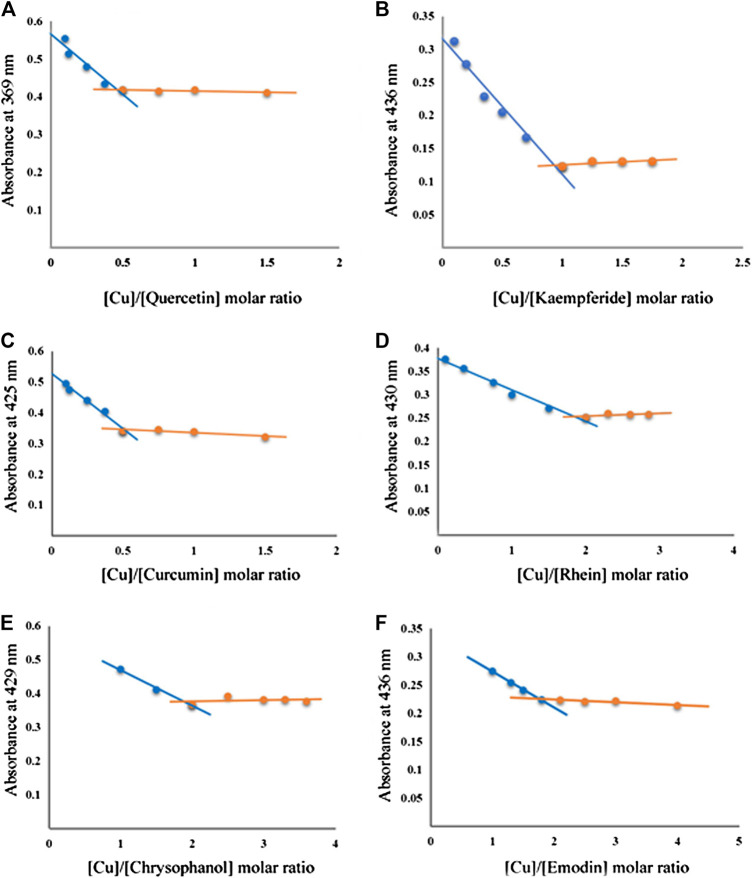
The plot of the absorbance at λmax vs. mole fraction of compounds. (A) quercetin; (B) kaempferide; (C) curcumin; (D) rhein; (E) chrysophanol; (F) emodin.